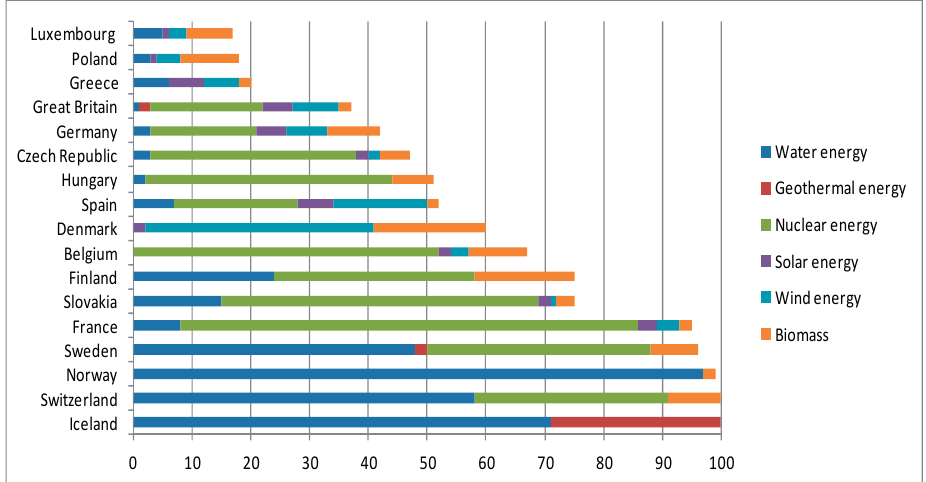
Figure 7. Share of low-emission sources in electricity production in 2018 (in terms of percentage) [51,52].